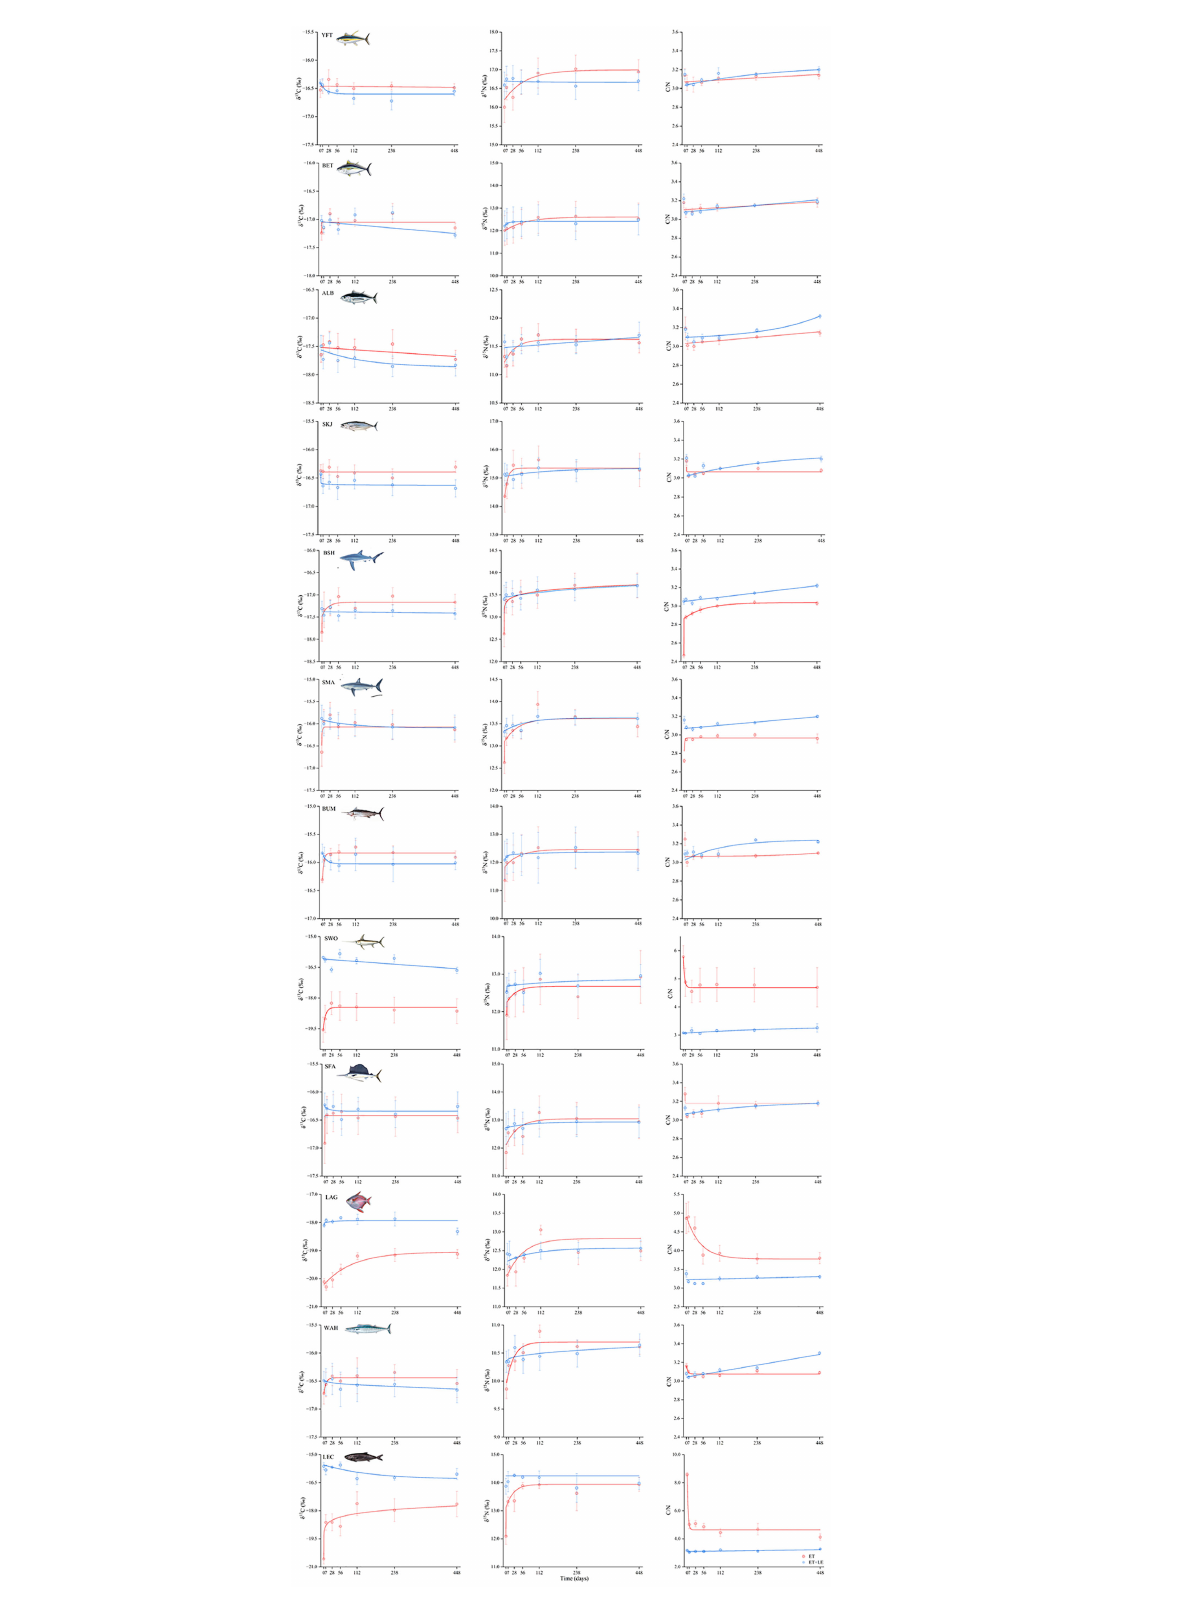
FIGURE 1 Time series data of mean±SE of d 13 C and d 15 N value and C/N ratios in twelve pelagic predators ’ muscle stored ethanol (red) and combined ethanol storage and lipid extraction